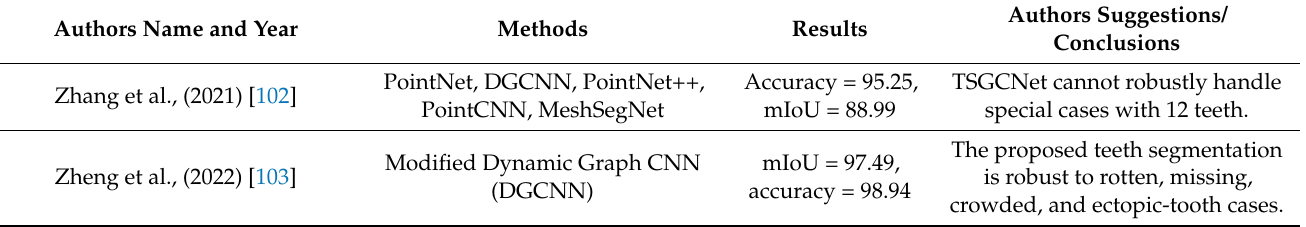
Table 7. GNN selected